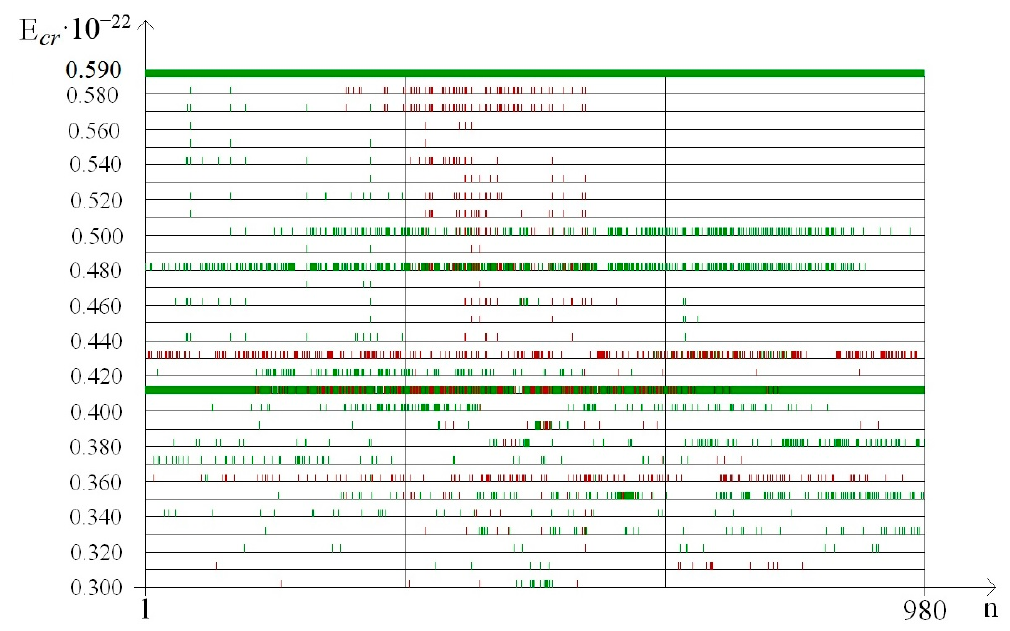
Figure 3. Distribution in the different parts of interferon alpha 17 (IFNA17) of nucleobase pairs (which was counted by decile method) leading after the single 2 H/ 1 H replacement the extreme frequency of open state (OS) occurrence. Note: red dot is the location of the deuterium atom in the DNA molecule, which leads to the maximum probability of OS occurrence (range); green dot is the location of the deuterium atom in the DNA molecule, which leads to the minimum probability of OS occurrence (range).